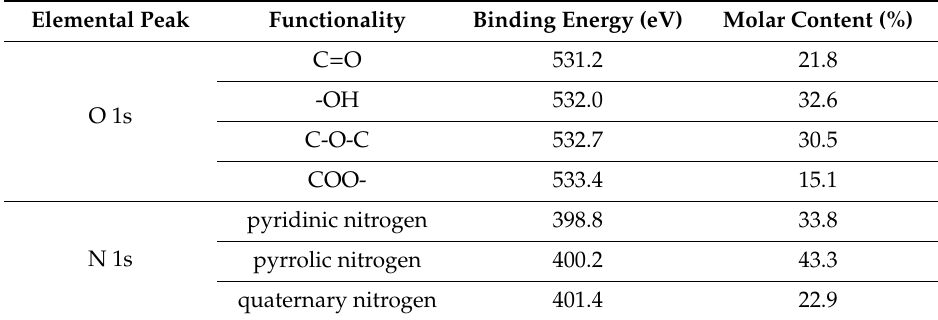
Figure 3. Experimental and calculated 13 C-NMR spectrum of the Bulianta coal.